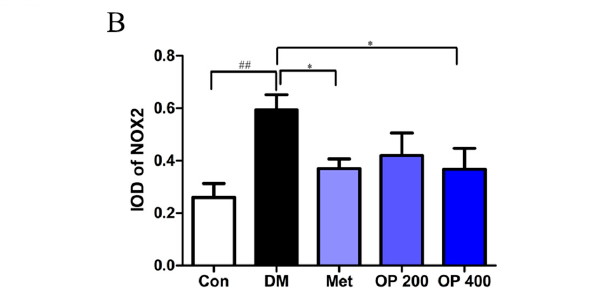
Figure 9. Effect of OP treatment on the T2DM-induced nicotinamide adenine dinucleotide phosphate oxidases 2 (NOX2) expression in the liver (Diaminobenzidine (DAB) staining, 200×). ( A ) Representative photographs were shown for the mouse livers in the different groups. ( B ) IOD of the NOX2 by Image-Pro Plus software 6.0 analysis. Results are represented as mean ± SD (n = 3). ## p < 0.01 vs control, * p < 0.05 vs model.